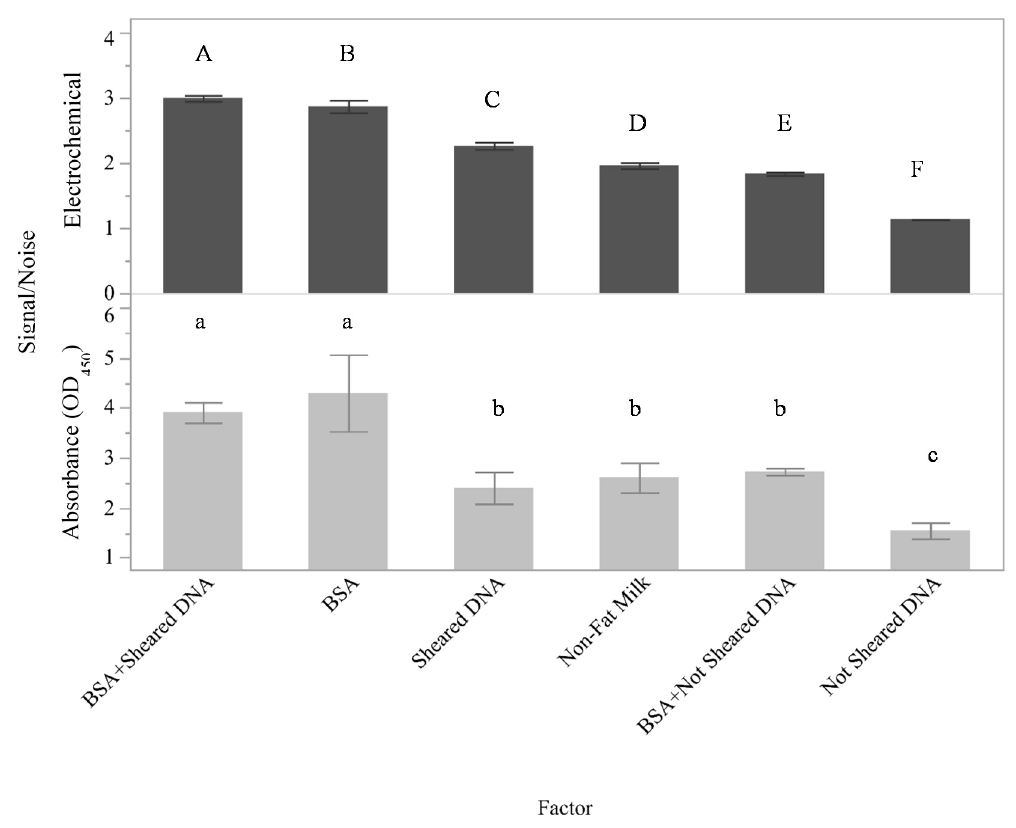
Figure 2. Effects of blocking agents on assay signal. Blocking agents tested are presented as categorical variables along the x-axis while signal-to-noise ratios for both the electrical currents generated using the flow through electrochemical sensor ( top ) and the corresponding absorbance readings at 450 ( bottom ) are presented on the y-axis. The mean of three independent trials is plotted with the error bars representing the standard deviation and statistical differences amongst samples noted by the connecting letters report. Levels not connected by the same letter are significantly different.